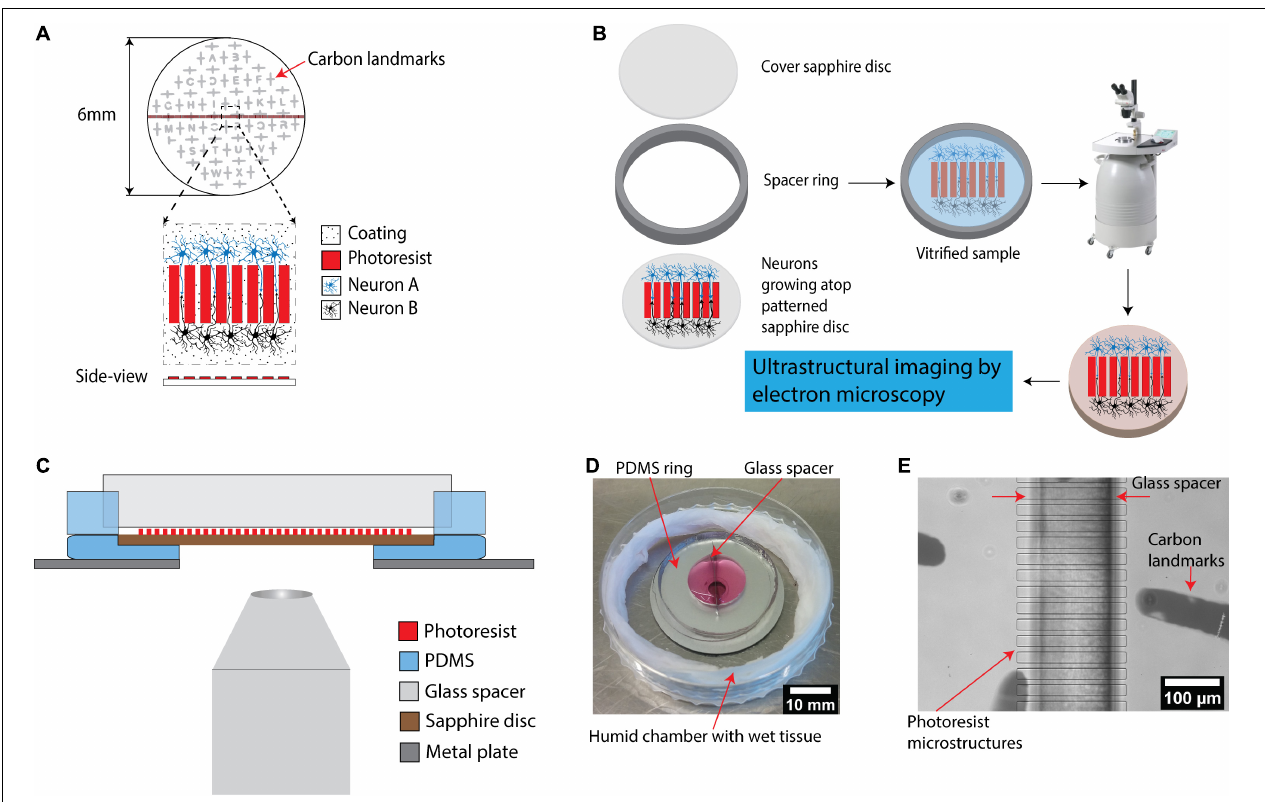
FIGURE 1 | A microstructured device for in vitro reconstruction of neuronal networks and ultrastructural imaging. (A) Schematic of the microstructured sapphire disks used as cell-growth substrates. Parallel ridge structures are lithographically fabricated on sapphire disks using a biocompatible SU-8 negative tone resist. The structures are guiding neurites originating from neurons of two different populations for neuronal circuits’ reconstruction. An evaporated carbon pattern serves as landmarks in the downstream processing. (B) Experimental workflow for ultrastructural imaging: cryo-fixation of cells grown on the structured disks via high pressure freezing, followed by freeze substitution is utilized to preserve cellular ultrastructure for downstream electron microscopy. (C) Schematic illustration of an assembled device allowing compartmentalized co-culture of different cell populations. It includes two main components: a PDMS ring with a glass spacer to form two isolated chambers for co-culture, and a PDMS base with a central hole holding patterned sapphire. The whole system is placed on top of a stainless steel ring as a support. The assembled device is compatible with light microscopes to enable correlative light-electron microscopy. (D) Picture of an assembled PDMS device. The device is placed into a home-made humidity chamber with a wet tissue to maintain humidity. (E) Image of the patterned sapphire disk inside the PDMS device recorded using an inverted microscope. The photoresist ridge structure, the glass spacer separating the two chambers as well as the carbon landmarks were clearly